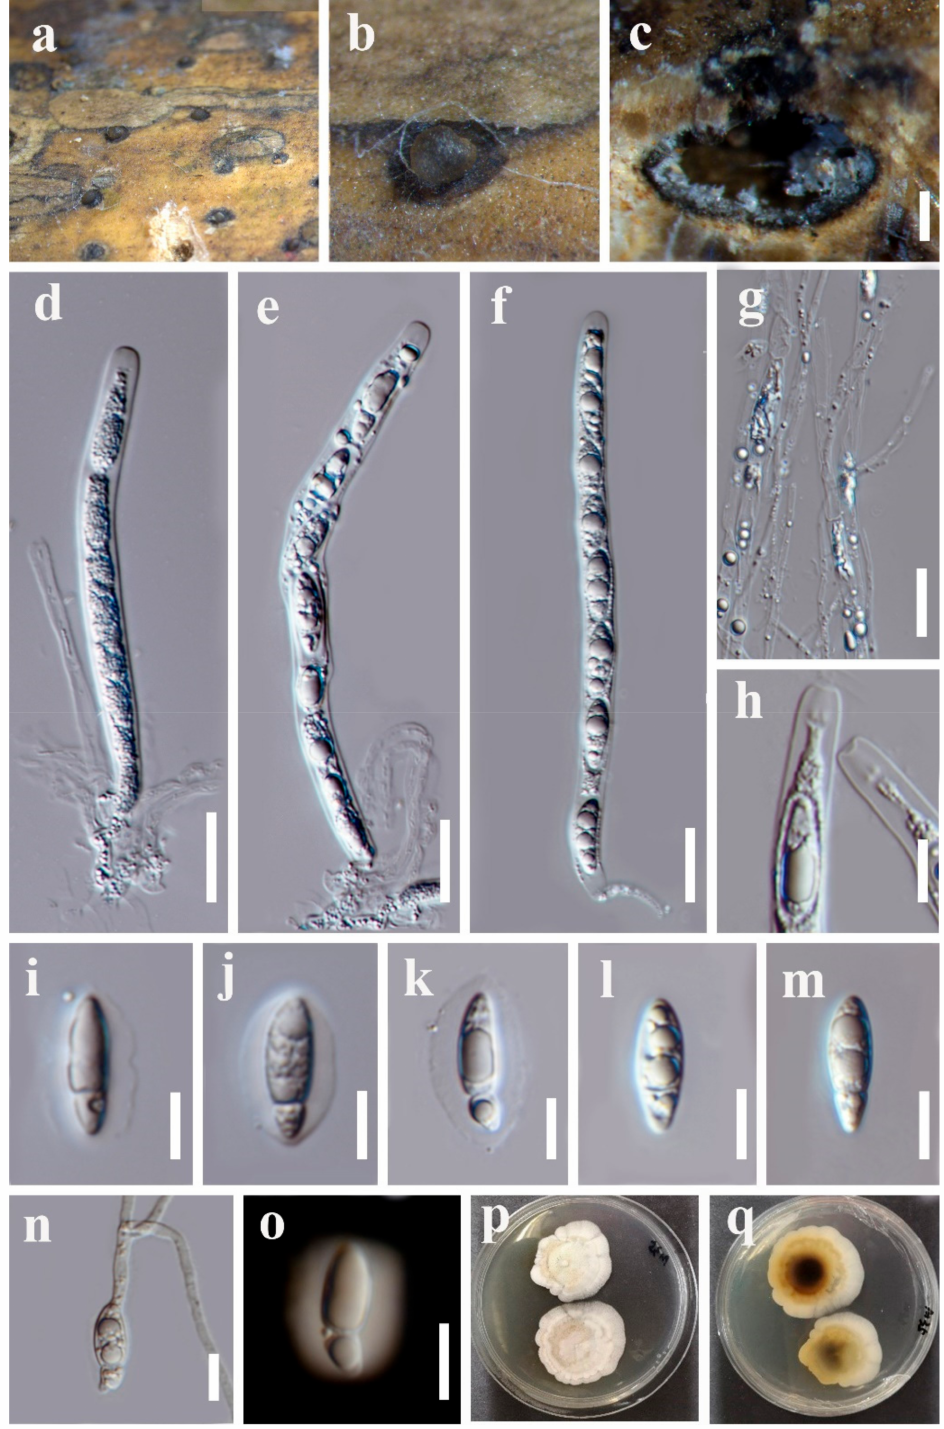
Figure 4. Vamsapriya chiangmaiensis (MFLU 21-0087, holotype) ( a , b ) Appearance of ascomata on host substrate. ( c ) Vertical section of ascoma. ( d – f ) Asci. ( g ) Paraphyses. ( h ) Apical ring of asci. ( i – m ) Ascospores. ( n ) Germinated ascospore. ( o ) Ascospore stained in Indian ink. ( p , q ) Colonies on PDA. Scale bars: c = 200 µ m, d – g = 20 µ m, f , h – o = 10 µ